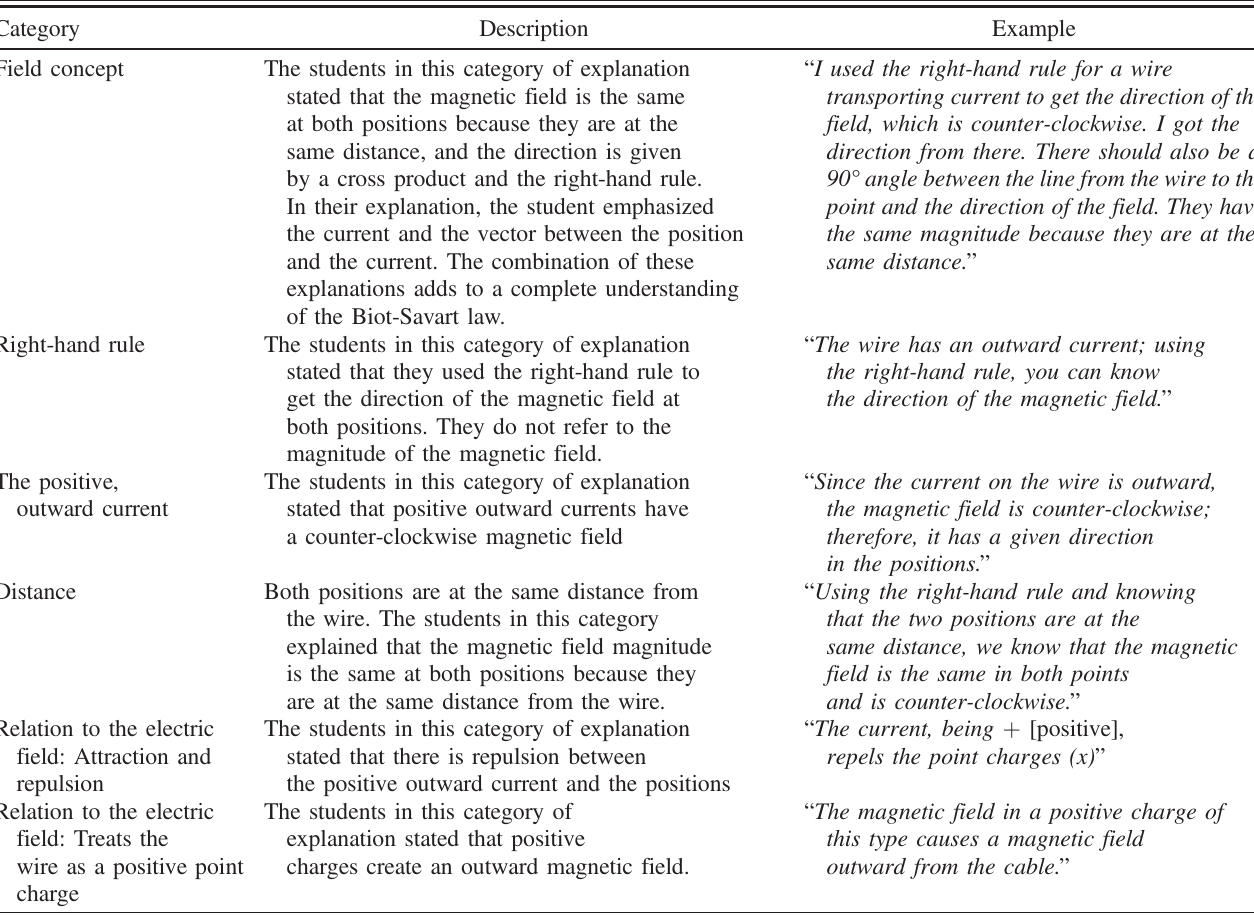
TABLE IV. We present the categories of explanation in the first question of the magnetic